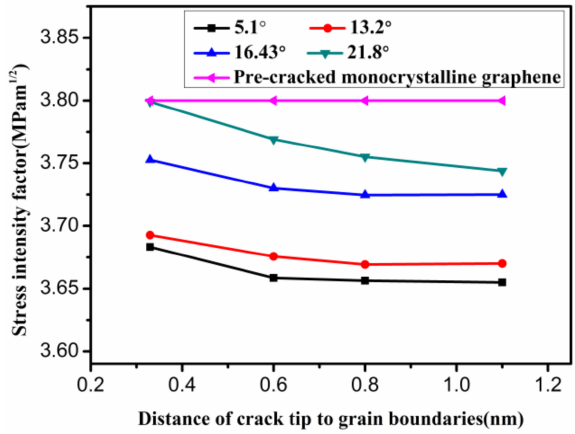
Figure 11. The mode I critical stress intensity factor of polycrystalline graphene with increasing distance between the crack tip and